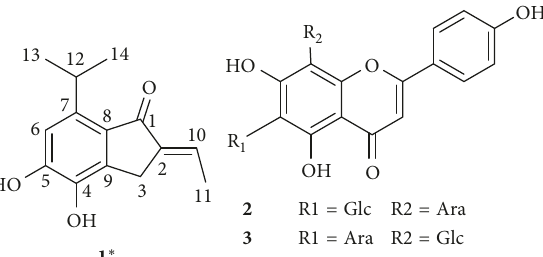
Figure 1: The structure of compounds 1 – 3 . ∗ New compound.